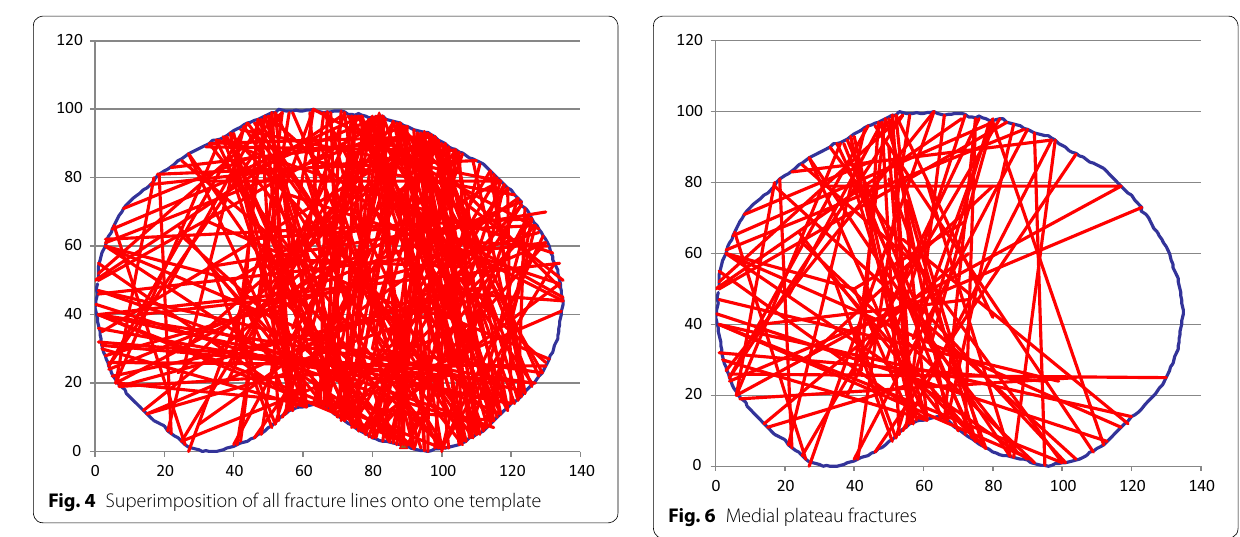
Fig. 6 Medial plateau fractures